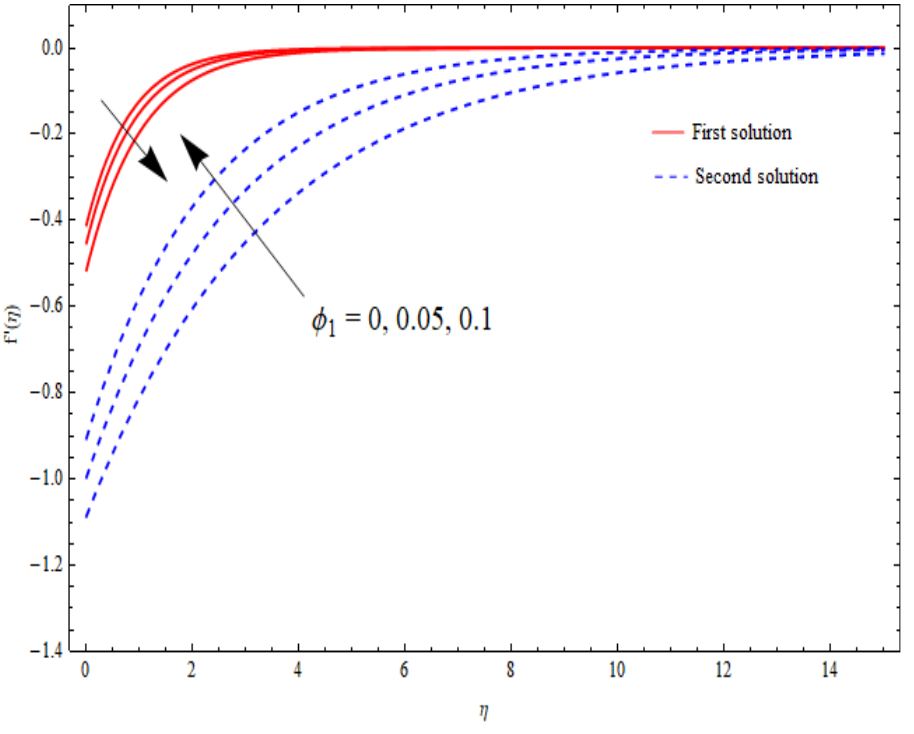
Figure 6. Velocity profiles f (cid:48) ( η ) for distinct δ when λ = − 1.5, k 1 = 1 = γ = s , ϕ 1 = 0.1 = ϕ 2 .